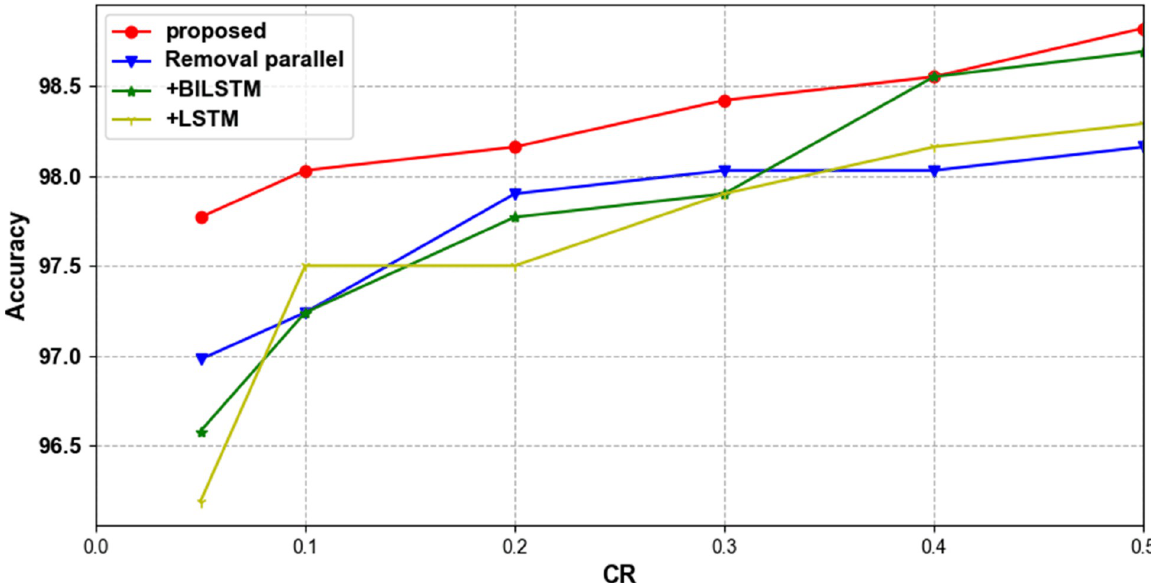
Fig 16. Accuracy trends using different classification methods at different compression ratios in the MIT-BIH ECG signal database.